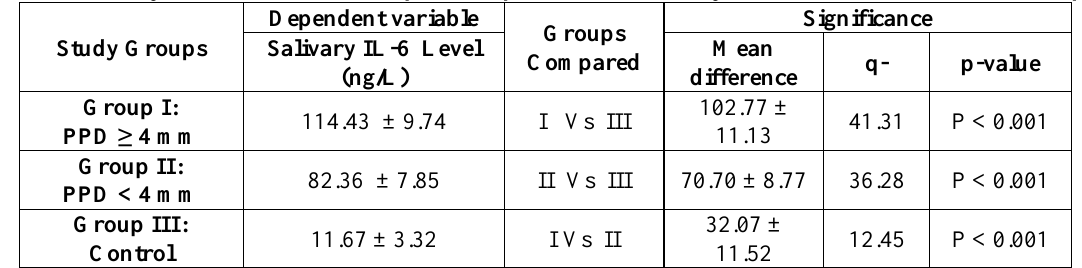
Table 3: Tukey's Test Results Multiple Comparison of Salivary IL-6 Level between the